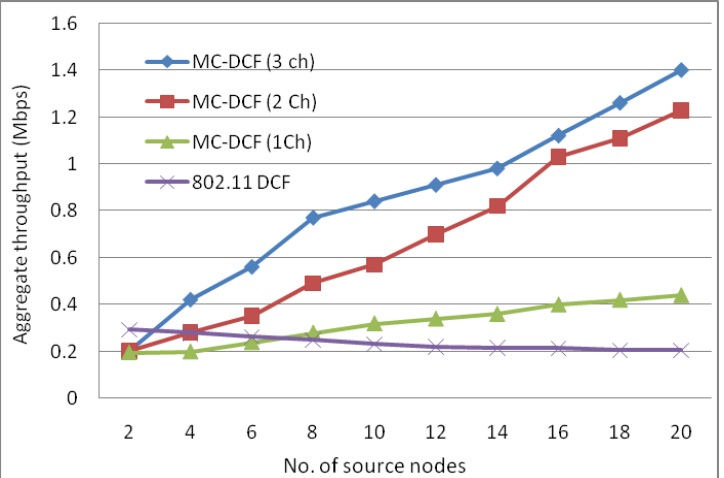
Figure 5. Throughput of the overall system using multiple sink nodes with single radio interface.